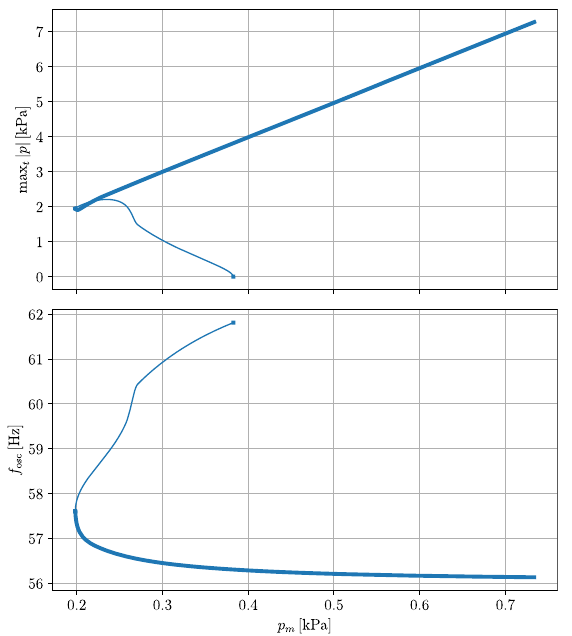
Figure 8. Top and bottom plots represent respectively the maximum amplitude of the periodic solutions branches and their oscillation frequency versus the blowing pressure in the case of a trombone, for f l ¼ f opt ; per l ; = 54.86 Hz. The line thickness 1 indicates whether the branch portion is stable (thick line) or unstable (thin line).